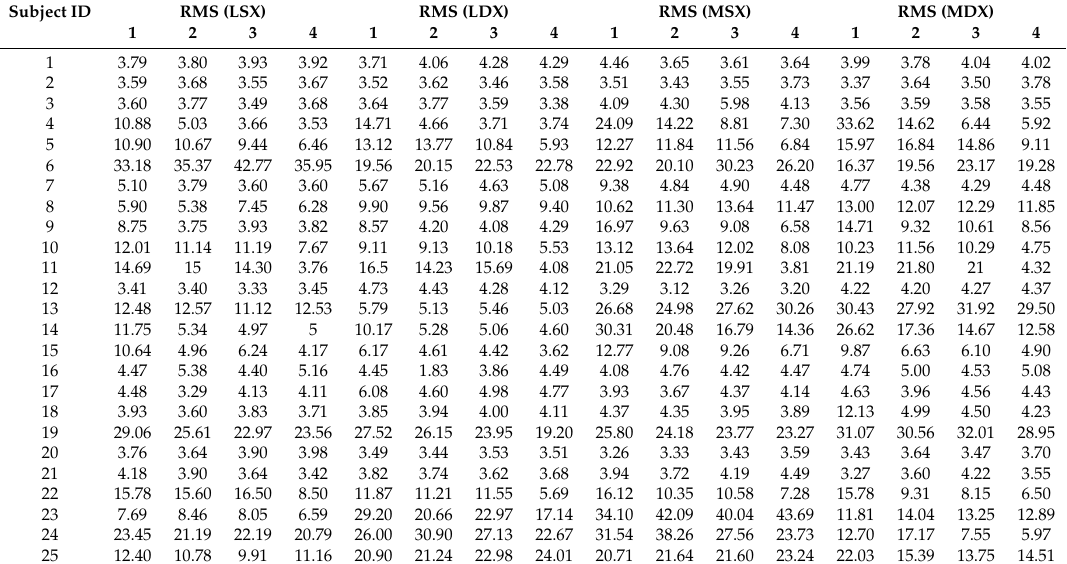
Table 1. Representation of the RMS values: the mean is calculated for each FF’ cycle as represented in Step 6 of Figure 7.